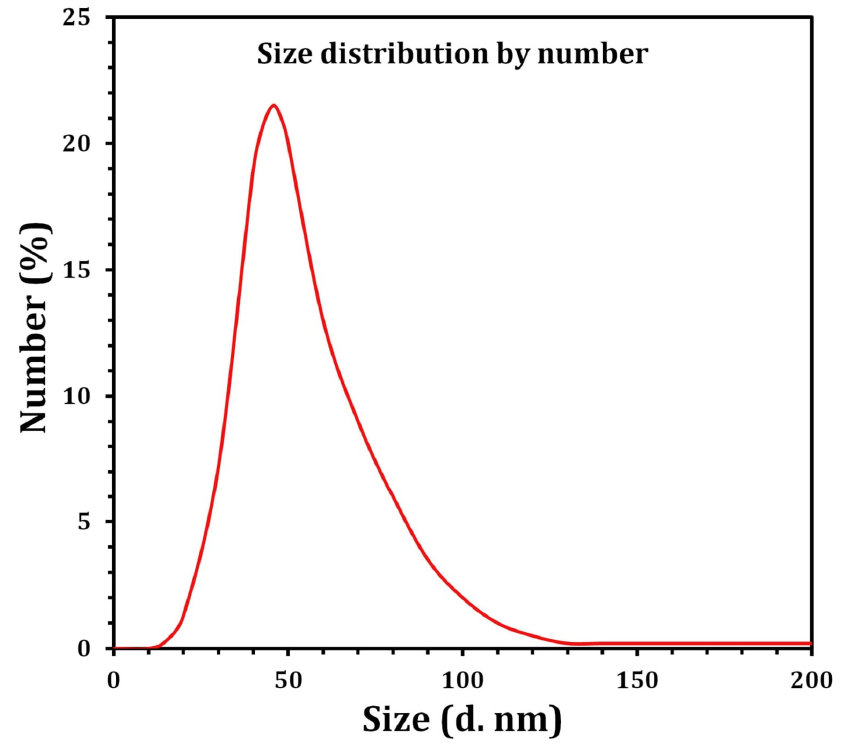
Figure 6. Size distribution by the number graph of the SNPs as revealed by DLS.